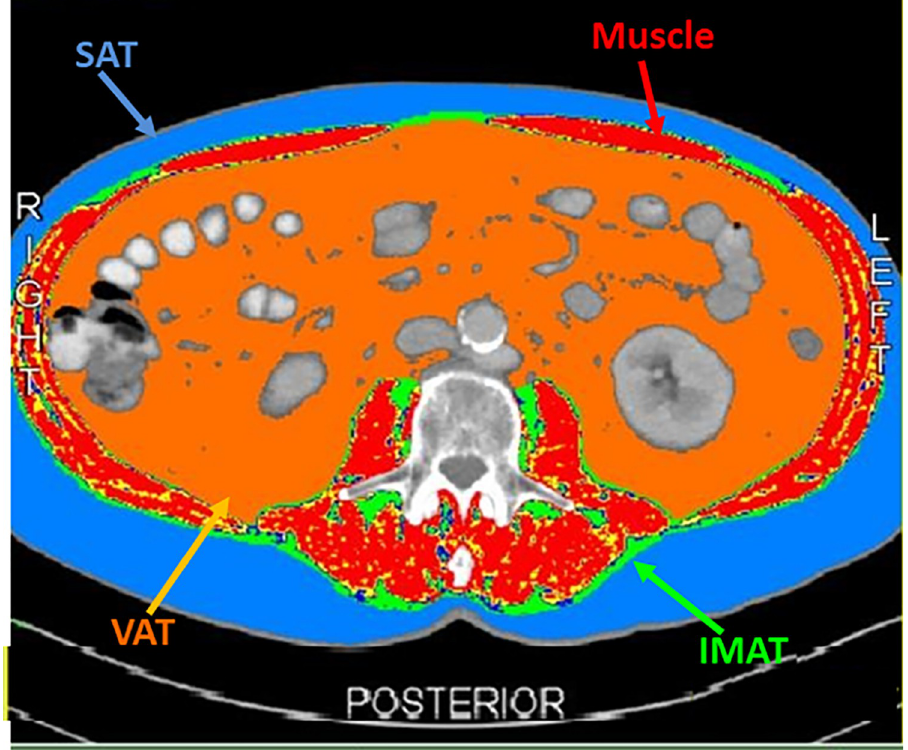
Fig 1. SliceOmatic tomovision analysis of the computed tomography scan of a male patient distinguishing the different context of Visceral Adipose Tissue (VAT), Intramuscular Adipose Tissue (IMAT), Subcutaneous Adipose Tissue (SAT) and skeletal muscle according to their differential Hounsfield Units (HU)